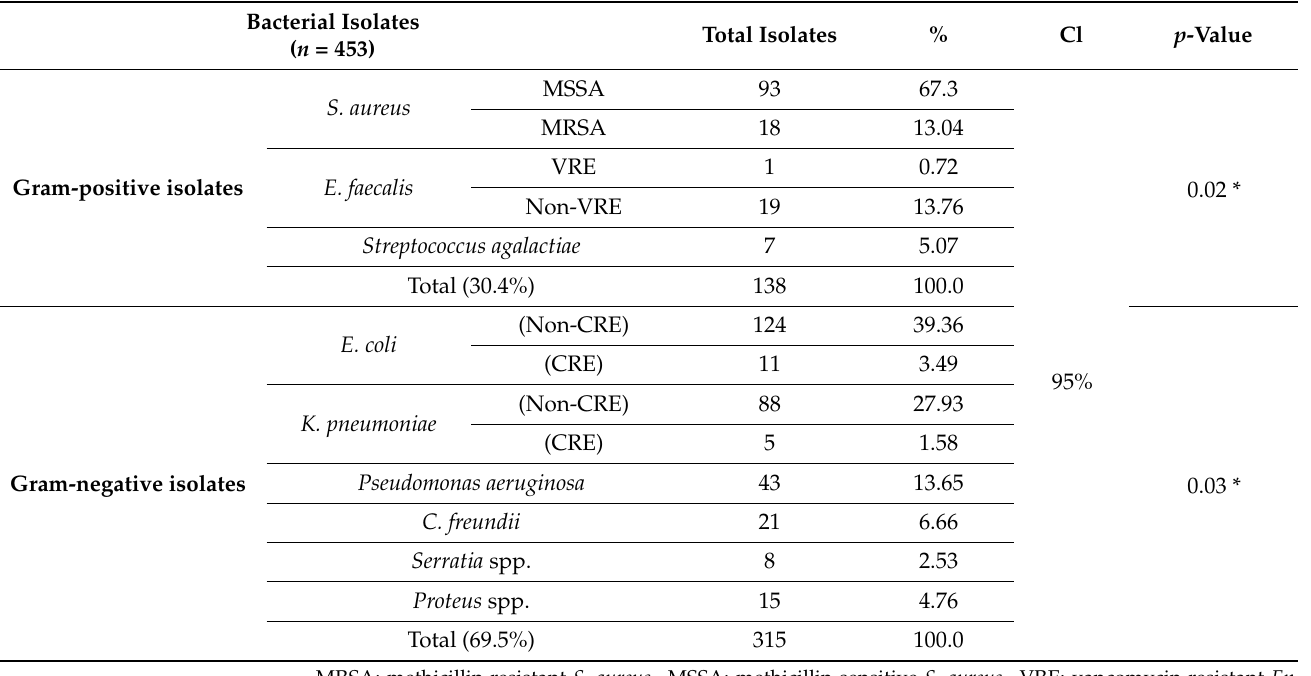
Table 2. Prevalence of bacterial isolates among the tested patients ( n = 453).